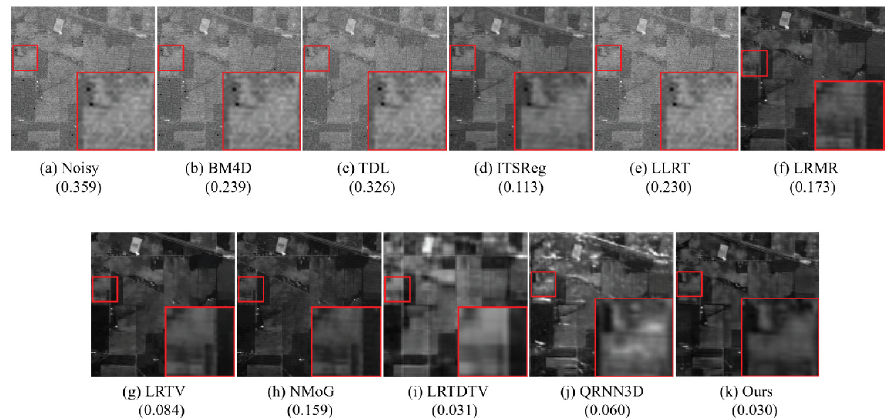
Figure 7. The denoised results on band 2 of the Indian Pines dataset for all the competing methods.